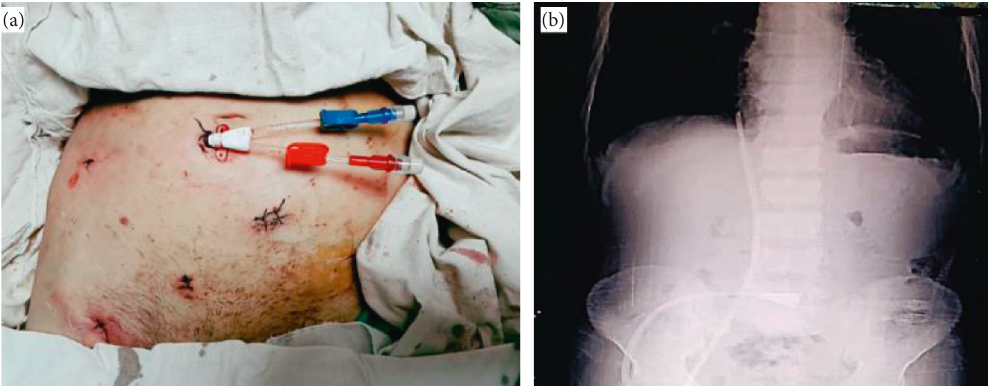
Figure 1: Right iliac approach of the tunneled cuffed catheter. (a) shows the position of catheter exit site below the umbilicus away from the groin making a low possibility of exit site infection. (b) Plain X-ray of the chest and abdomen shows the smooth curve of the tunnel, and the catheter tip is directed upward in the inferior vena cava till the cavo-atrial Table 1: Demographic data and patient characteristics. Parameter